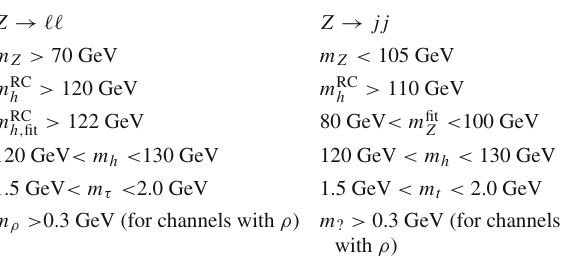
Table 2 Further kinematic cuts applied to enhance the signal signifi- cance Z → (cid:3)(cid:3)